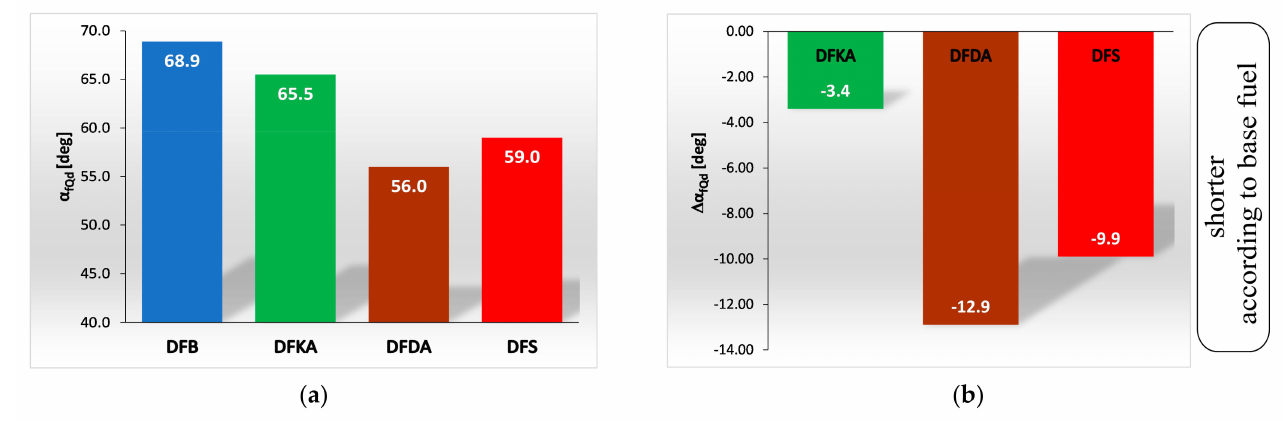
Figure 25. ( a ) Duration of diffusion phase ( α fQd ) for tested fuels. ( b ) Percent change ( ∆ α fQd ) for tested fuels relative to α fQd for DFB (base fuel).